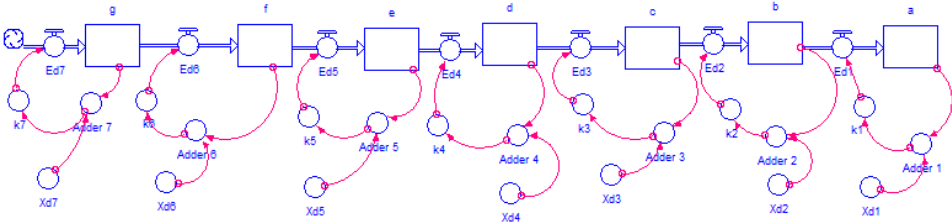
Figure 34. Forrester diagram of the packaging process, n = 7.